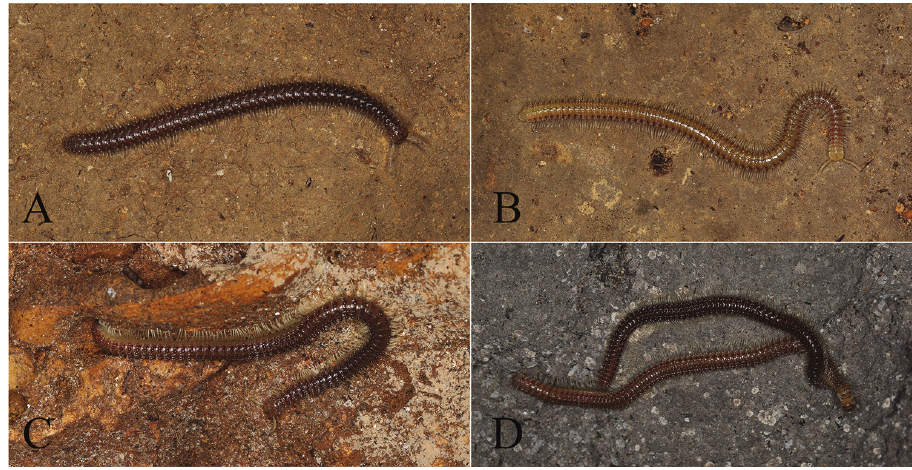
Figure 1. Living animals. A Glyphiulus foetidus sp. n. from Zhoubang Cave B Glyphiulus calceus sp. n. from Xianren Cave C Glyphiulus guangnanensis sp. n. from Miaopu Cave D Glyphiulus impletus sp. n. from Guanyin